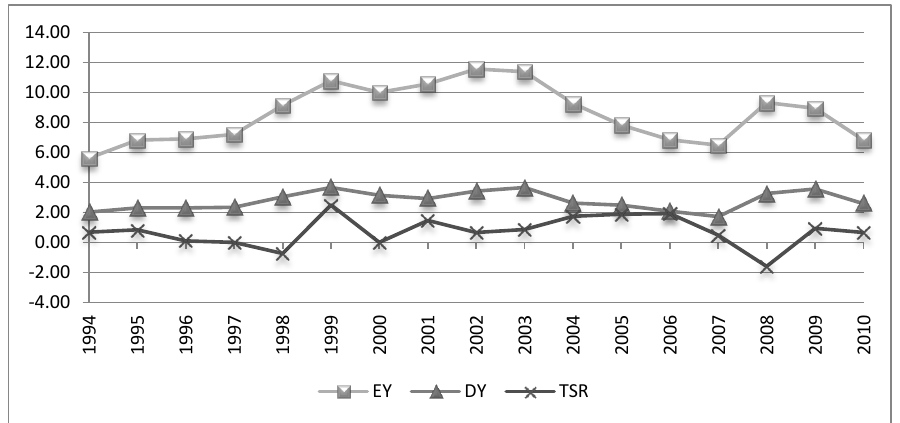
FIGURE 1: Median TSR, EY and DY values for the period 1994 to 2010